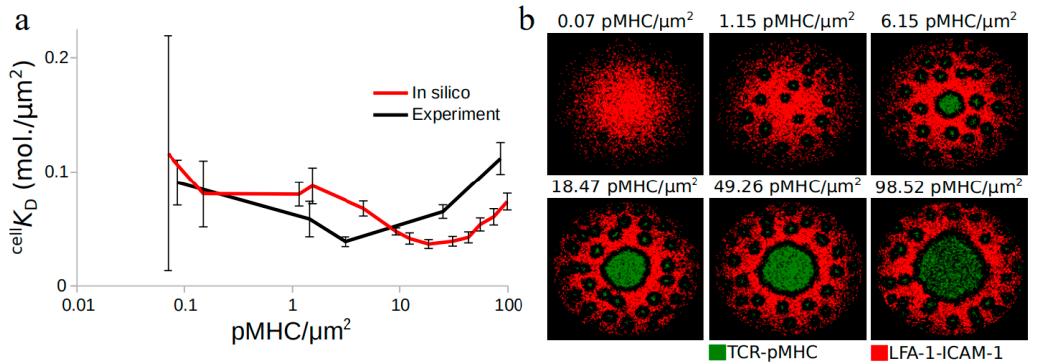
Figure 1. Observed T cell receptor (TCR) affinity modulation during immunological synapse (IS) formation: ( a ) in situ observed dissociation rate, cell K D , for different pMHCdensities and ( b ) immunological synapse snapshots after 10 min of contact initiation for different pMHC densities. Data were extracted from Pielak et al. [11]. TCR–pMHC: green, leukocyte function-associated antigen-1–intercellular adhesion molecules-1 (LFA-1–ICAM-1): red. Error bars represent SD of N = 10